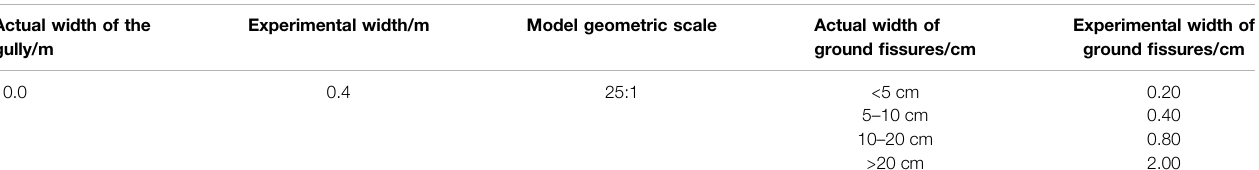
TABLE 2 | Summary of experimental fi ssure